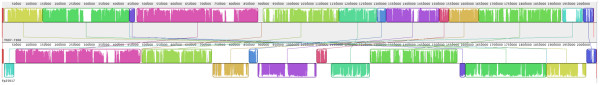
 Alignment of the chromosomes of strains TX07-7308 (top) and ATCC 25017 (bottom) using MAUVE 2. Identically colored boxes, known as locally collinear blocks (LCBs), depict homologous regions in the two chromosomes. The edges of LCBs indicate chromosome rearrangements due to recombination, insertions, and/or inversions. Sequences of strain ATCC 25017 inverted in relation to those of strain TX07-7308 are shown as blocks below the horizontal line. The vertical lines connecting the LCBs point to regions of homology among the two chromosomes. Numbers above the maps indicate nucleotide positions within the respective chromosomes.